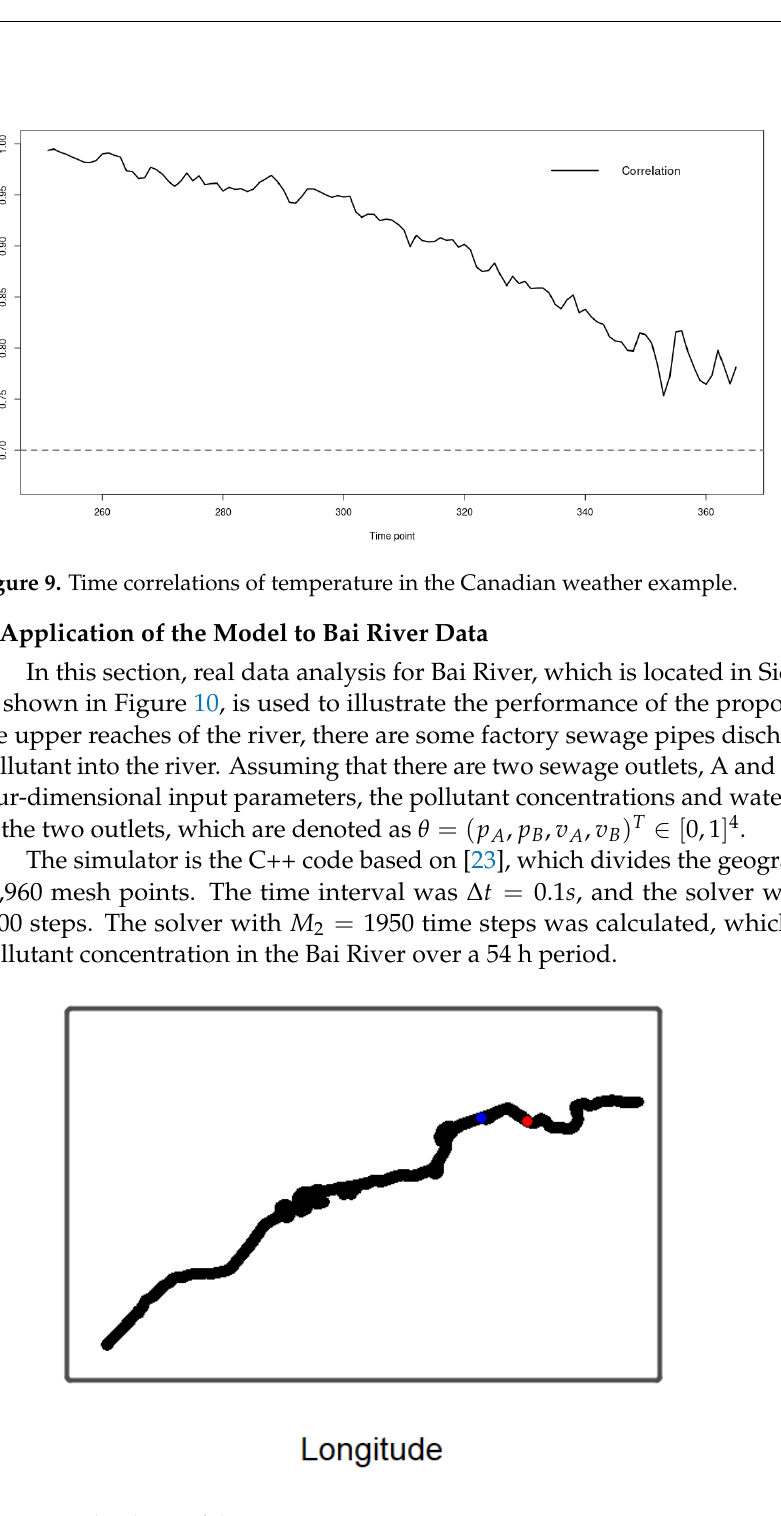
Figure 10. The shape of the Bai